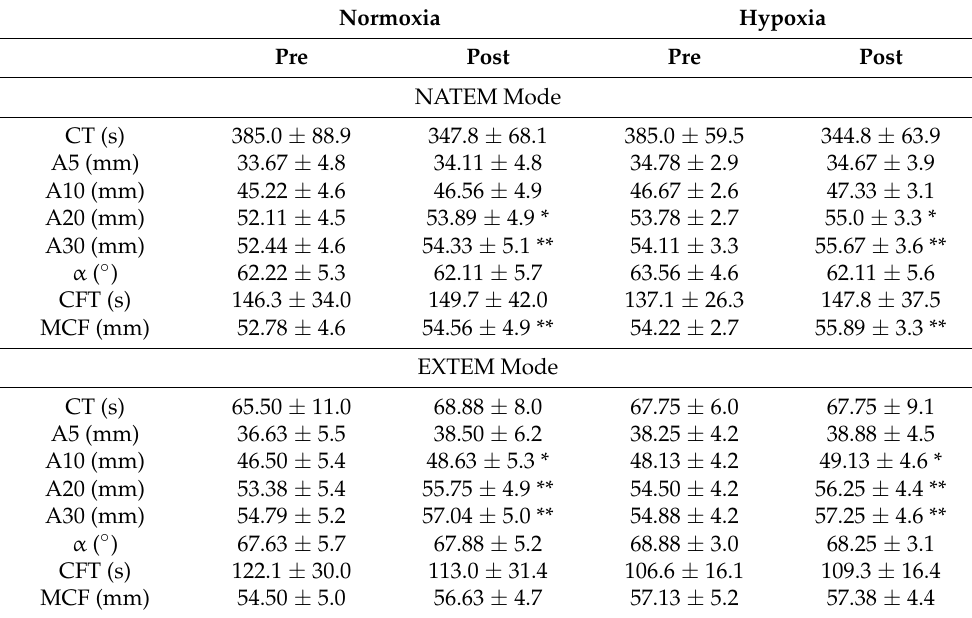
Table 4. Rotational thromboelastometry parameters in NATEM and EXTEM